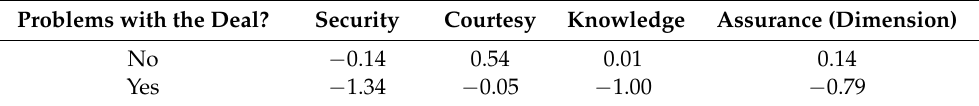
Table 10. Average service quality score for groups with and without problems during the timber deal. Differences between groups are significant on all items ( p < 0.01).